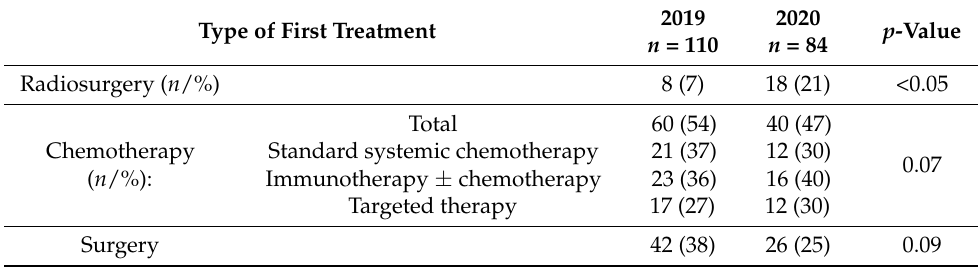
Table 3. Type of first